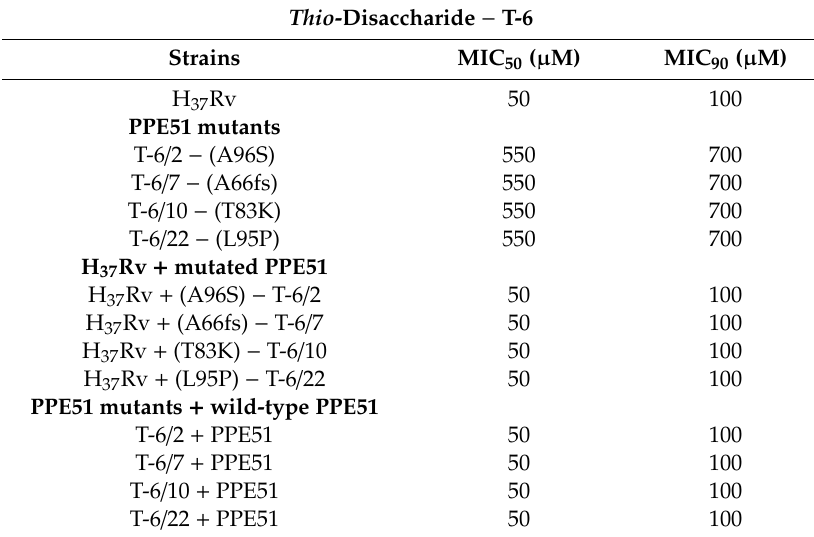
Table 1. The minimal inhibitory concentrations of thio -disaccharide T-6 against wild-type Mtb, resistant mutants and complemented